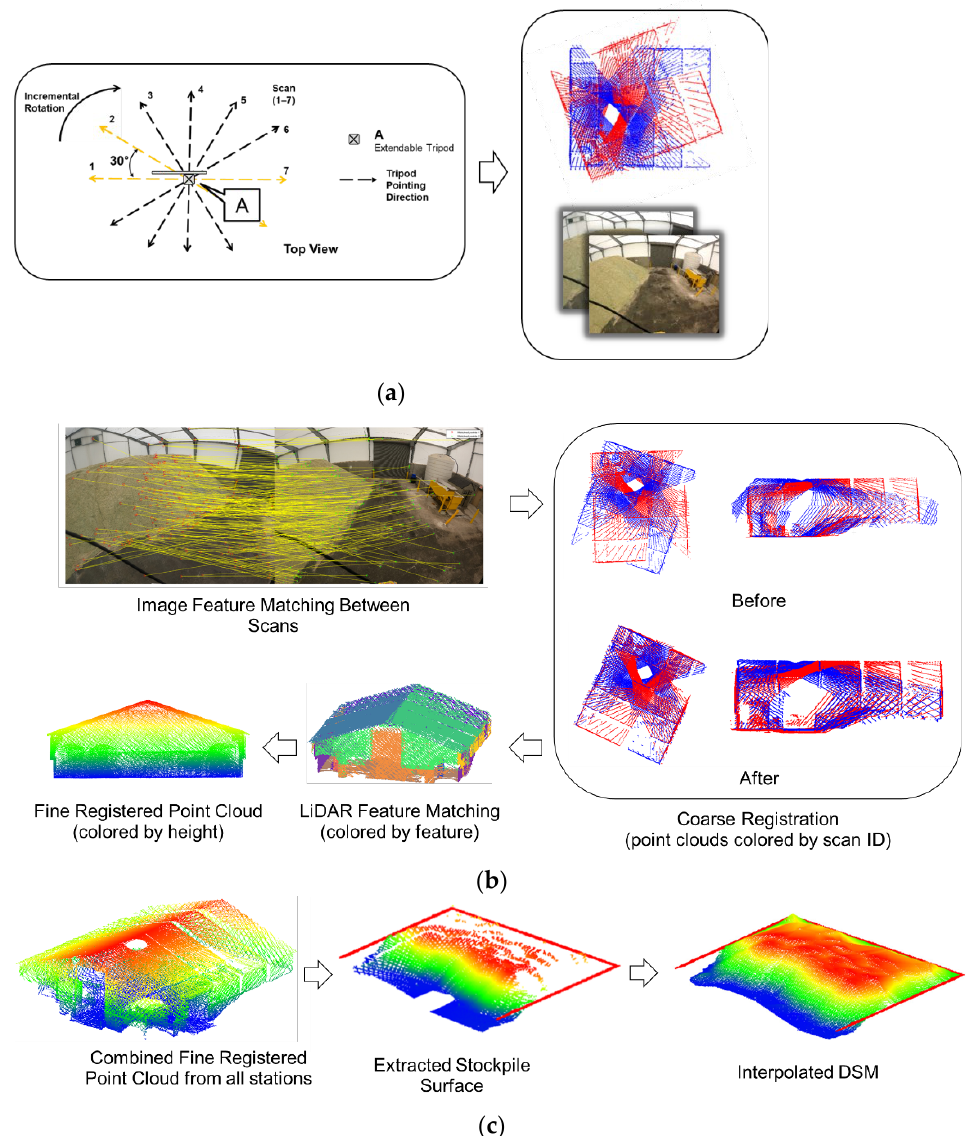
Figure 4. SMART data acquisition and processing methodology ( a ) diagram of system rotation for data collection ( b ) coarse registration of LiDAR scans ( c ) digital surface model of stockpile area.